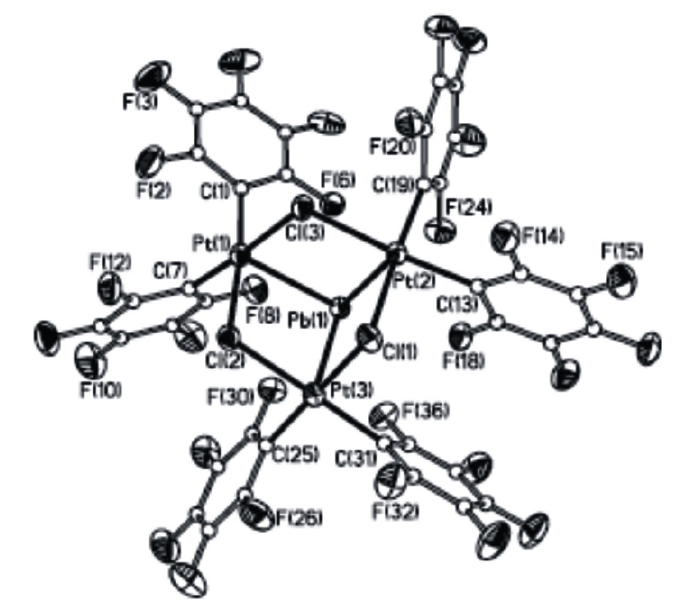
Figure 2. Structure of [{( η 1 -C